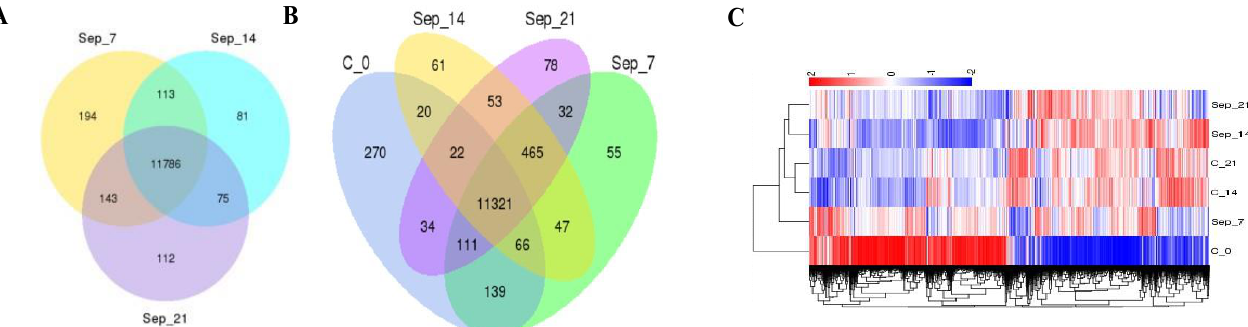
Figure 2. Sham surgery resulted in changes in gene expression over time ( A ), which was to a certain degree observed in sepsis survivors ( B ). Distinctive gene expression was seen when comparing flies surviving 21 days after sepsis compared to one and two week survivors or control animals. Unique gene patterns at 7, 14, and 21 among sepsis survivors can be seen ( C ).